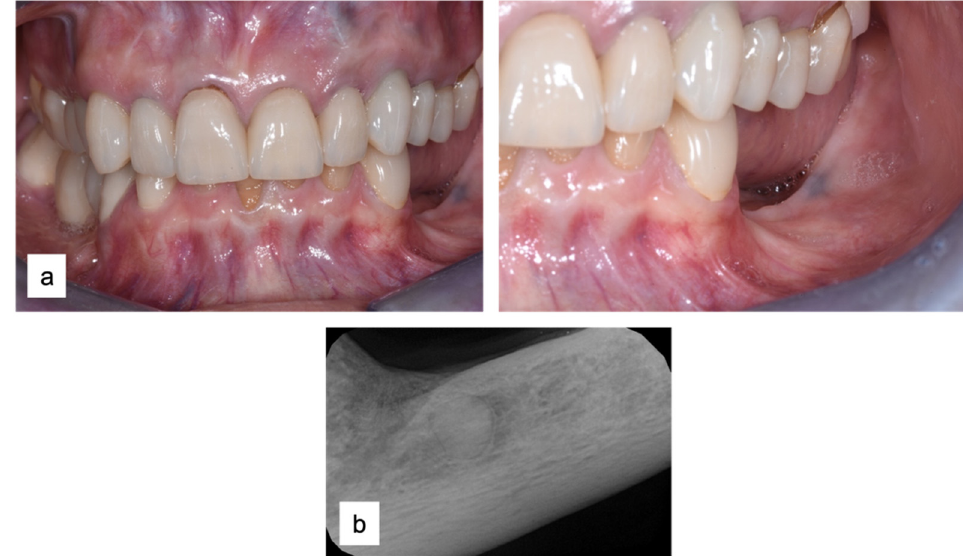
Figure 2. Consultation visit: ( a ) clinical evaluation at baseline; ( b ) periapical radiograph revealed the presence of a residual fragment of the root.